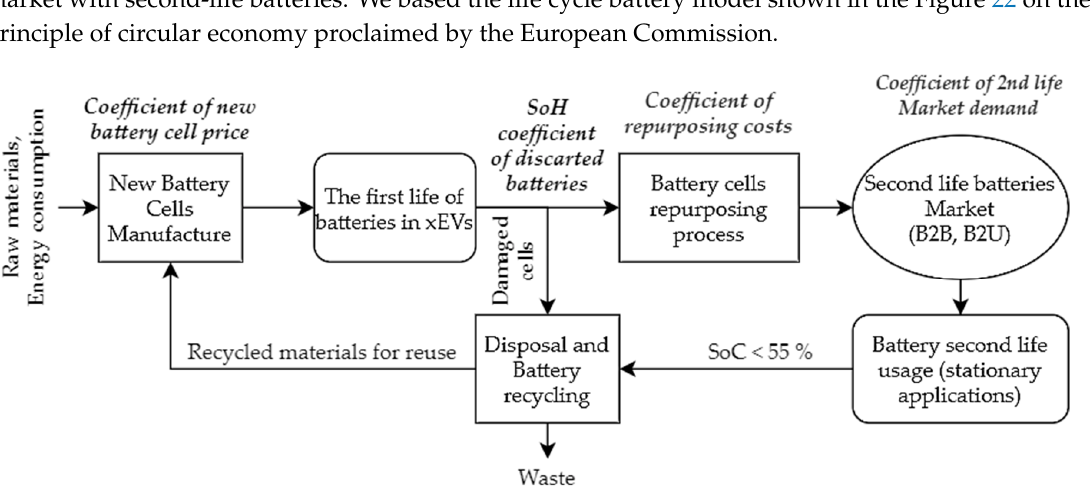
Figure 22. Battery cell circular life cycle. xEVs: electric vehicles.